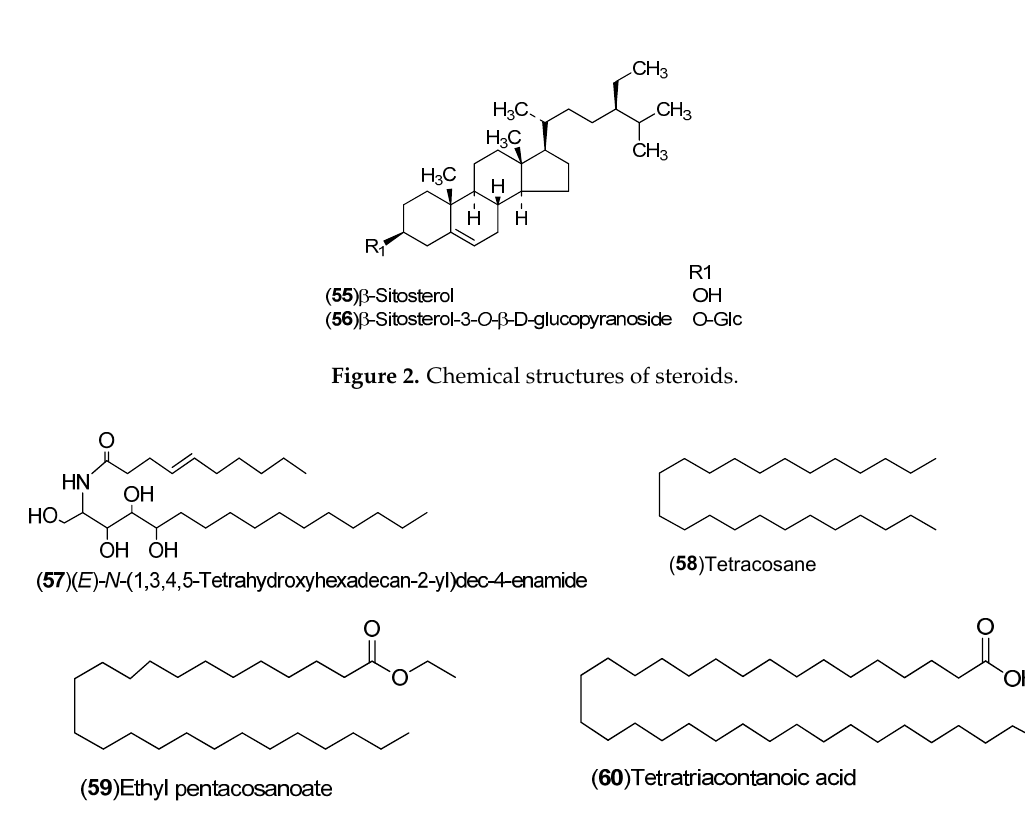
Figure 3. Chemical structures of hydroxyamides, alkanes and fatty acids.